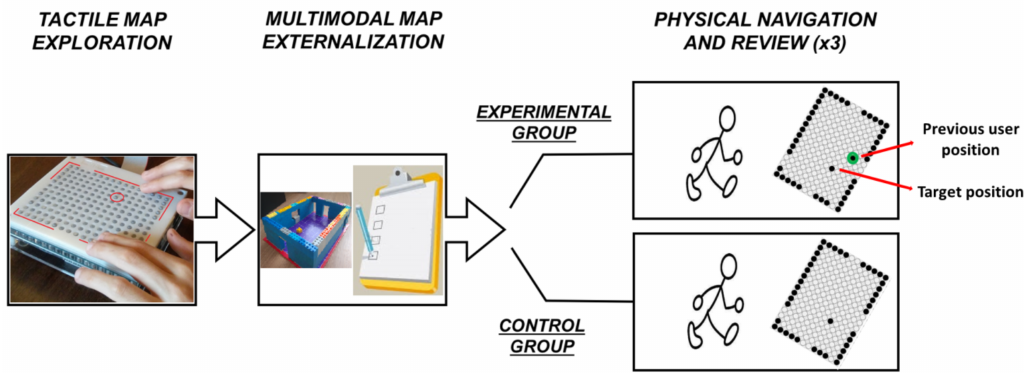
Figure 2. Procedure of a single session: both groups explored the map on BlindPAD, then externalized the map with LEGO modules and with a questionnaire; then, both groups navigated in the real room three times. The experimental group received feedback about the hypothesized (in green) and the target position, while the control group only reviewed the initial map. Each participant sustained four sessions: what varied was the displayed map, i.e., the different target positions as in Figure 1a. However, the control group only re-explored the same map before each navigation: the reviewed map only contained the target position. The goal was to account for learning effects